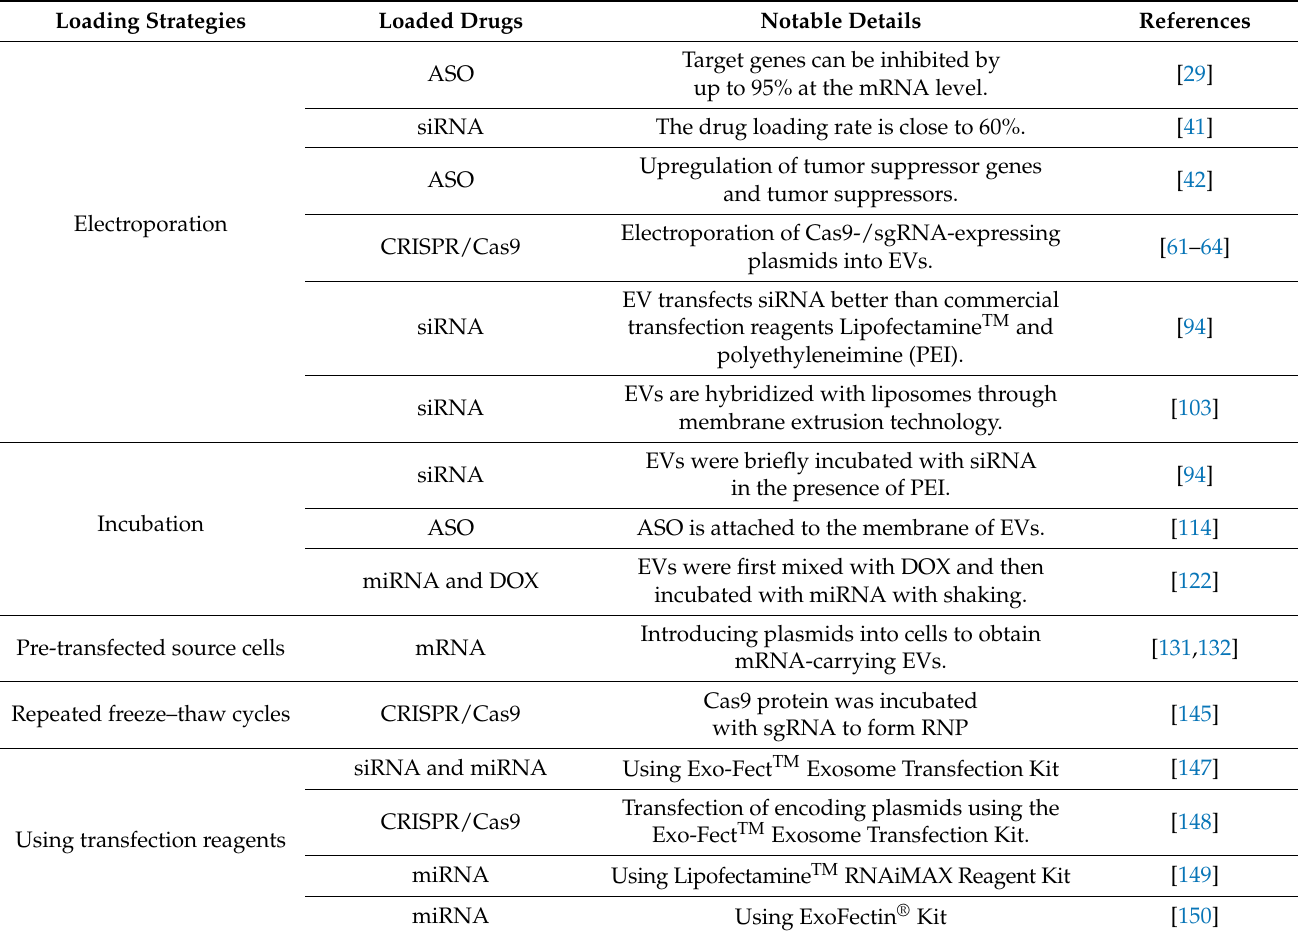
Table 2. A summary of various nucleic acid drug strategies encapsulated by